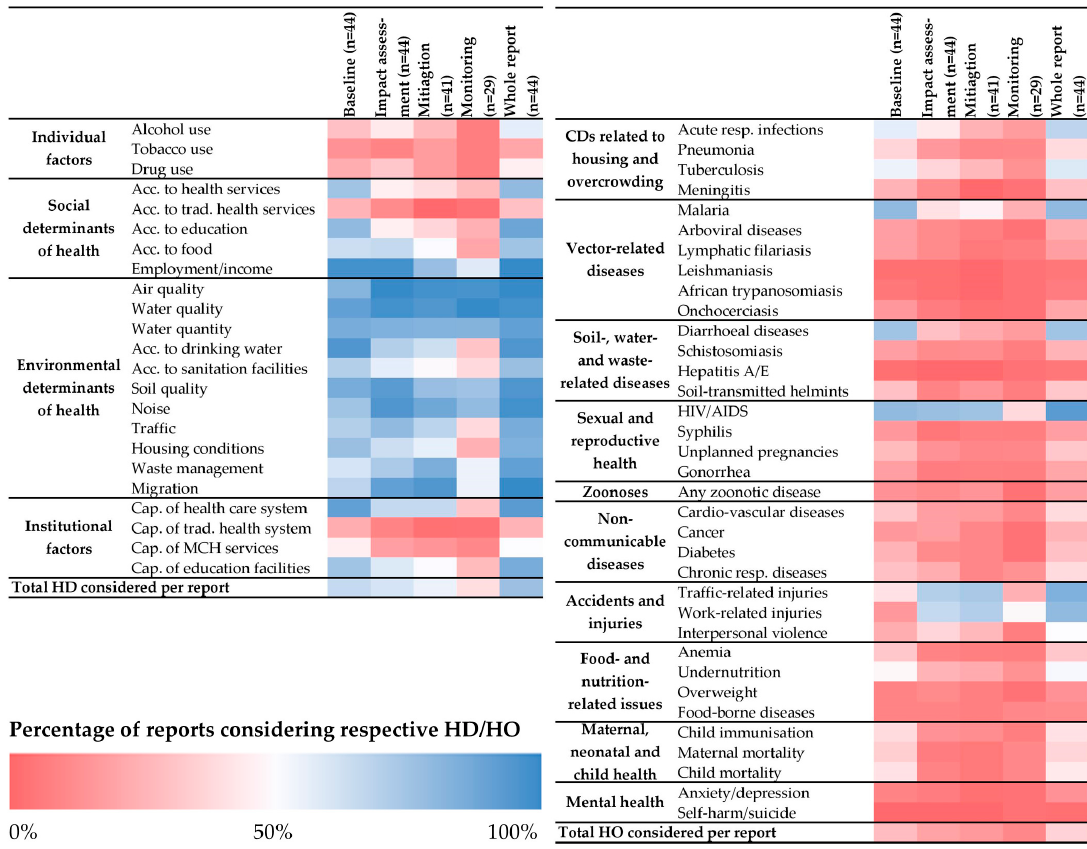
Figure 3. Inclusion of health determinants (HD; left panel) and health outcomes (HO; right panel) in impact assessment reports. Colors represent the percentage of reports or report sections considering the specific health aspect. Red shading indicates percentages below 50%, blue shadings above 50%. Acc. = access; Cap. = capacity; CD = communicable disease; MCH = maternal and child health; resp. = respiratory; trad. = traditional.